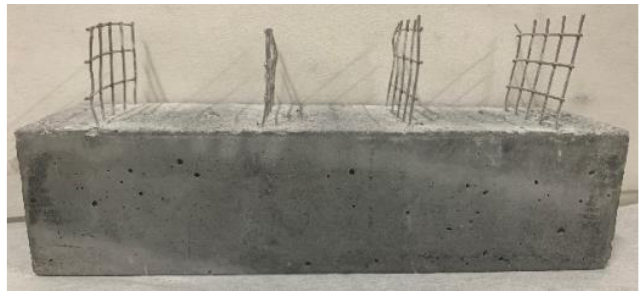
Figure 1. Resistivity test specimen.